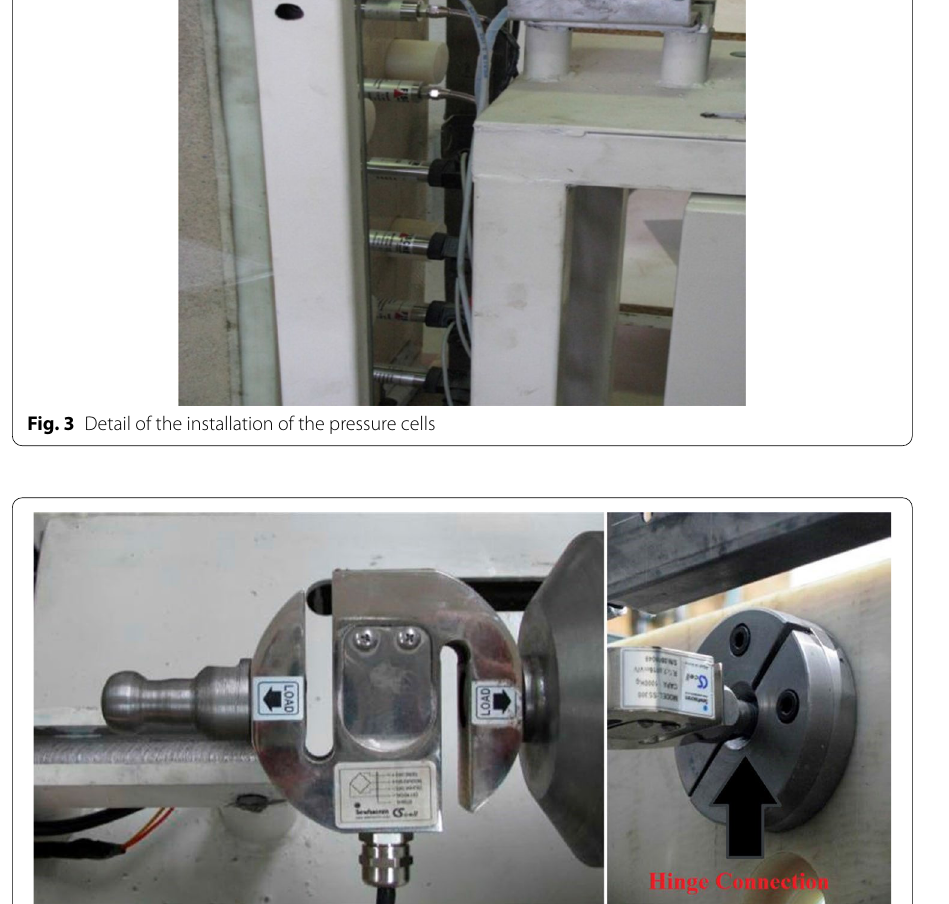
Fig. 4 View of the load cell and the hinge connection to the wall